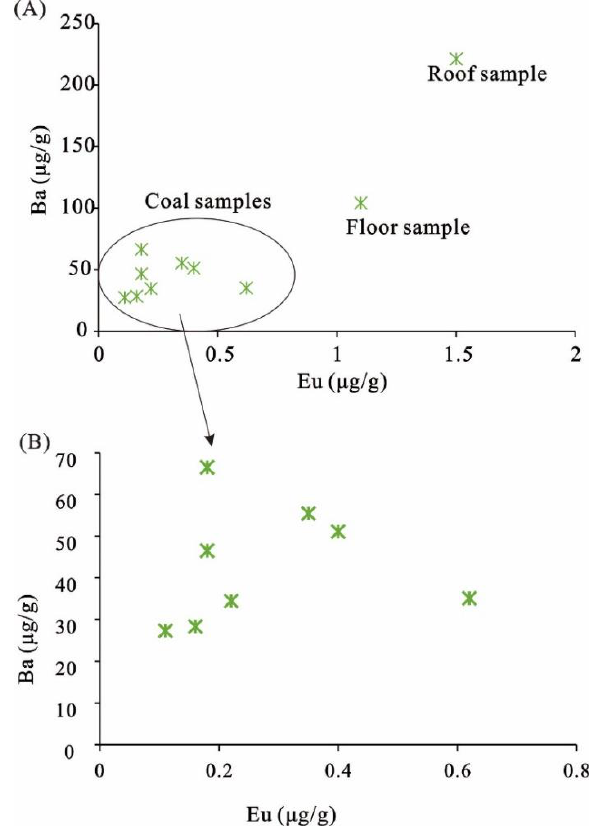
Figure 7. ( A ) Correlation diagram of Eu and Ba contents in coals, roof, and floor samples. ( B ) Magnification of relationship between Eu and Ba in coal samples from Junde mine. The contents of REY of No. 26 coal in the Junde mine (from 34.1 µ g/g to 174.6 µ g/g, average 80.6 µ g/g; Table 5) slightly exceed those in the world’s hard coal [53], but below those in Chinese coals [22] and the upper continental crust [58]. Table 5. REY geochemical parameters for the studied samples from the Junde